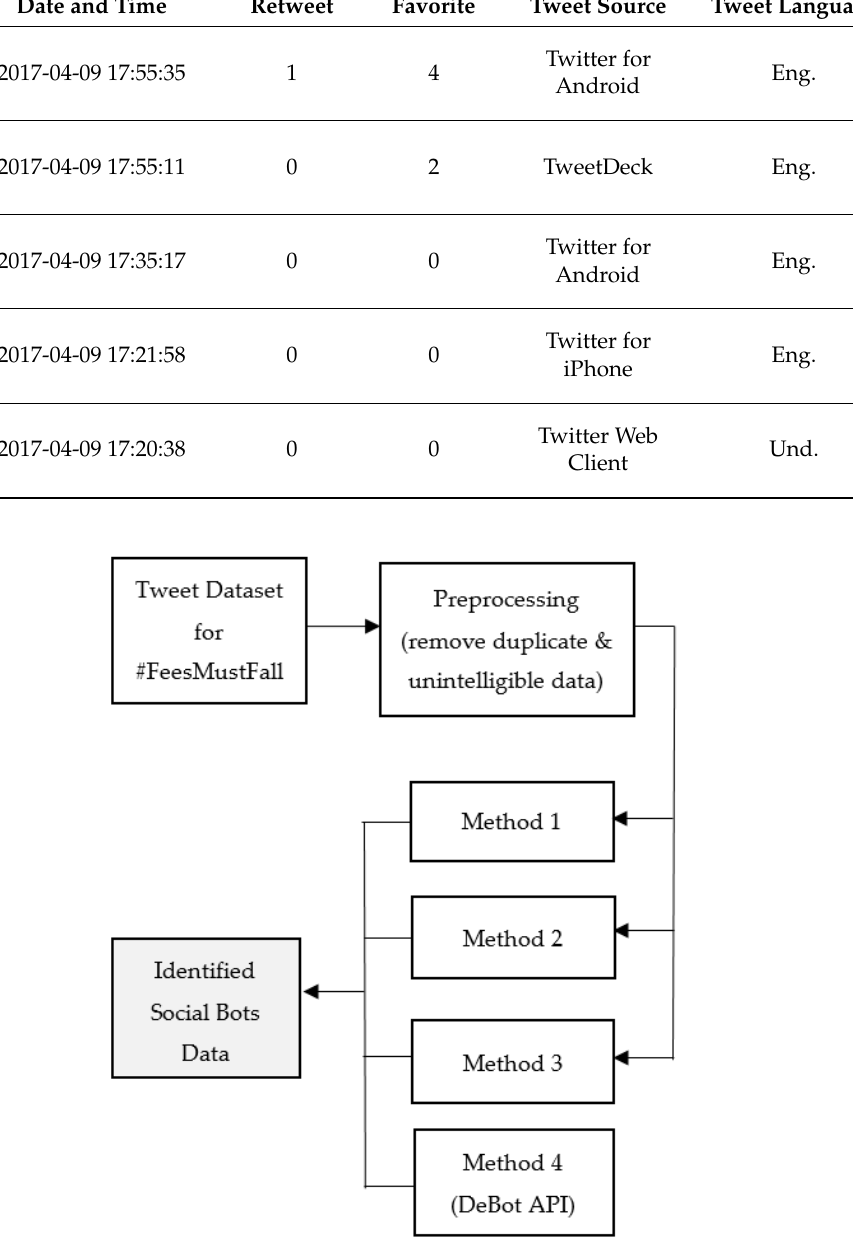
Figure 1. The data-driven detection process for the social